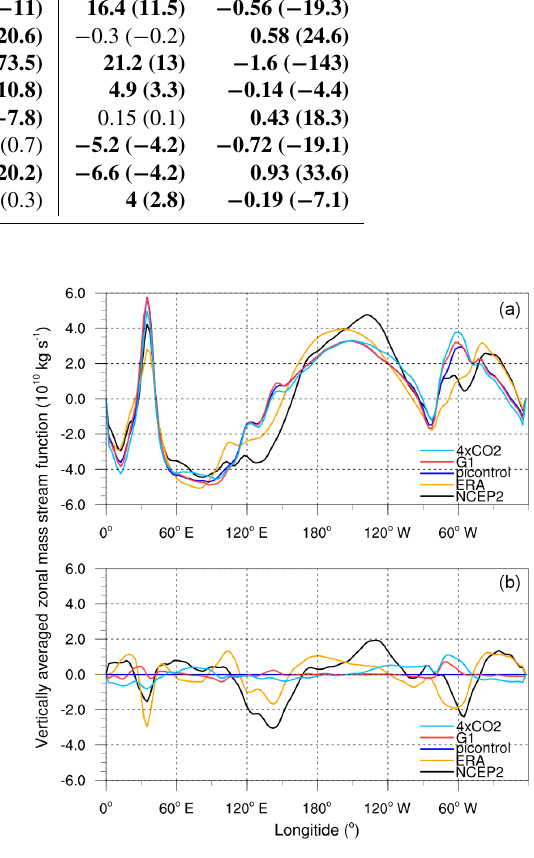
Figure 2. Shading indicates model ensemble mean zonal stream function anomalies (10 10 kgs − 1 ) G1-piControl (a) and abrupt4xCO2-piControl (b) . Warm colors (positive values) indi- cate a clockwise rotation and cold colors (negative values) indicate an anticlockwise rotation. Contours indicate the value of averaged meridional mass stream function (10 10 kgs − 1 ) in piControl as plot- ted in Fig. 1c.